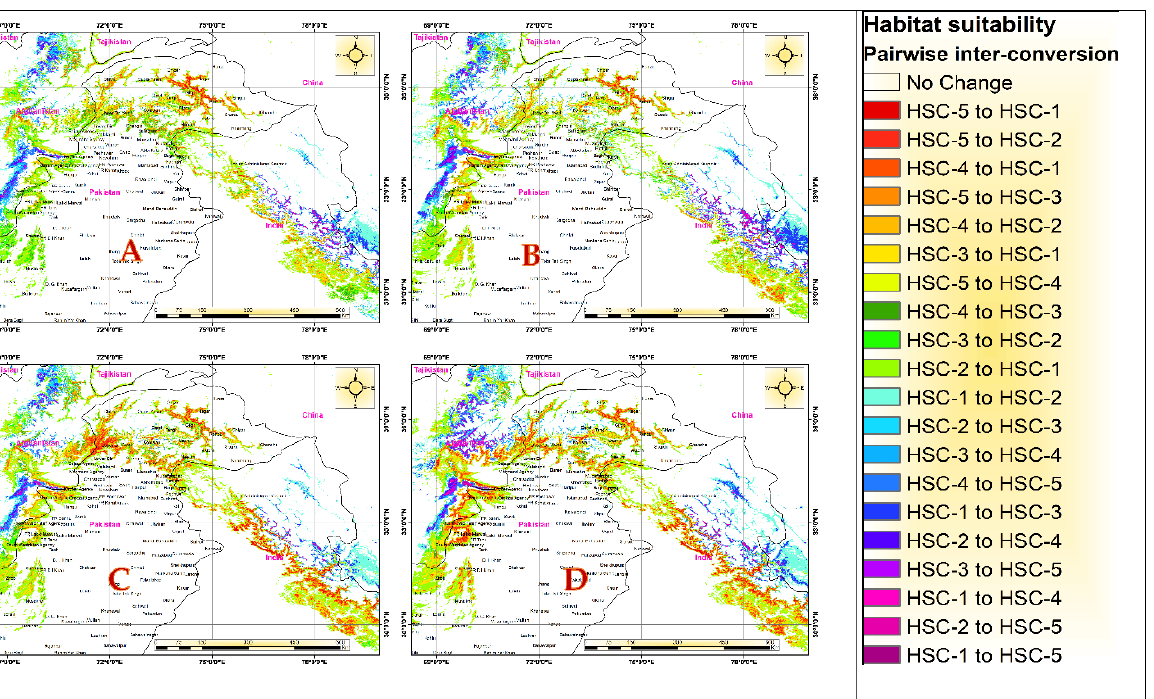
Figure 8. Maps showing pairwise inter-conversions of considered habitat suitability classes (HSC) of Chilgoza pine under four different climate change scenarios (HSC-1 = No suitability; HSC-2 = Least suitability; HSC-3 = Moderate suitability; HSC-4 = High suitability; HSC-5 = Very high suitability); ( A ) = SSPs 245; ( B ) = SSPs 585 of 2050s and ( C ) = SSPs 245; ( D ) = SSPs 585 of 2070s.